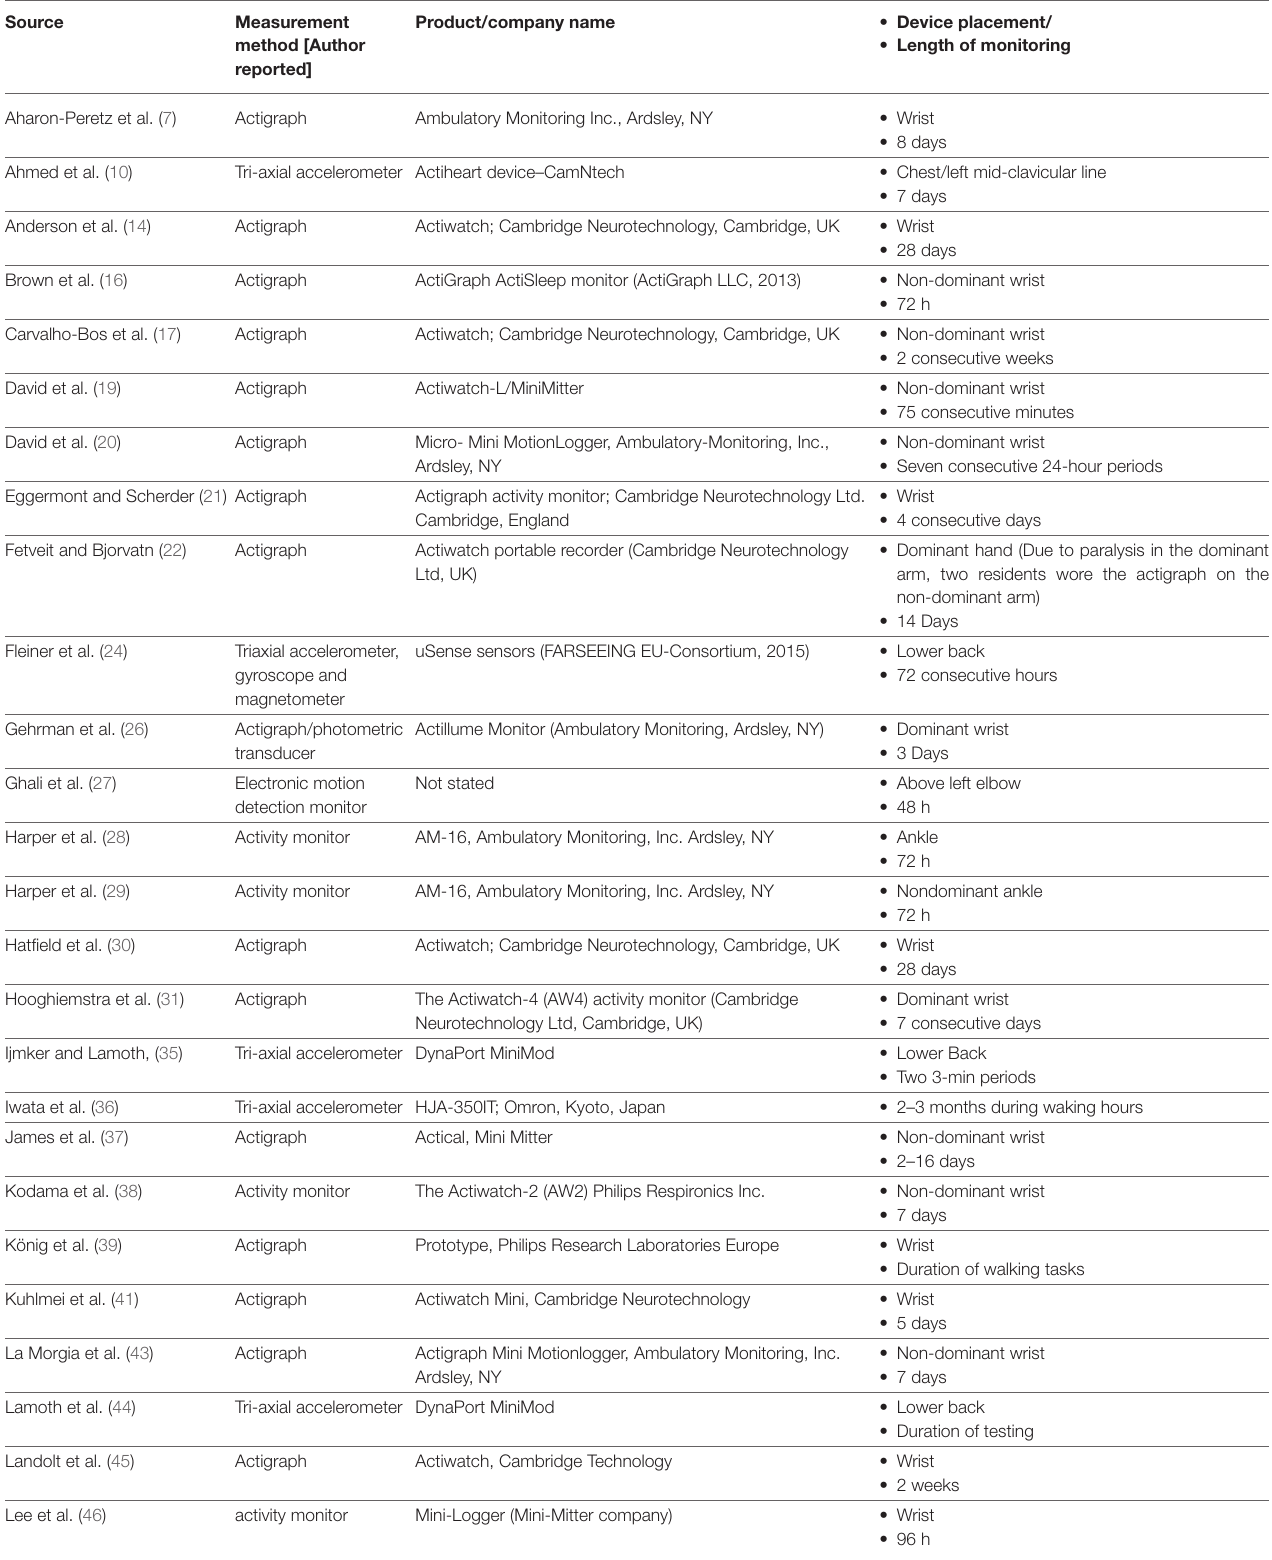
TABLE 2 | Technical specifications of wearable devices used in individual